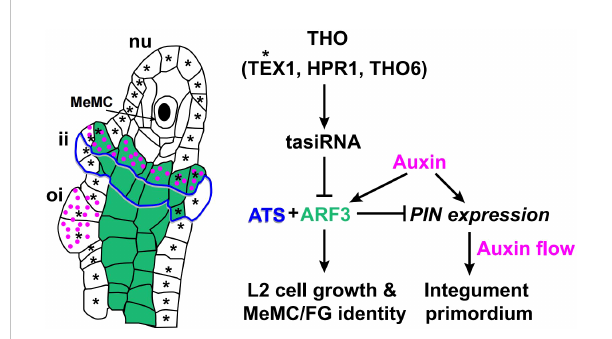
development. ARF3 is indicated in green, auxin in magenta, tasiR- ARF in gray, and ATS in blue with shades of gray (Kelley et al., 2012). Green area indicates the distribution of ARF3 (Su et al., 2017; Lora et al., 2019). The magenta dots indicate the distribution of auxin. Blue lines with shades of gray indicate the distribution region of ATS. Asterisks indicate the distribution of TEX1. Solid arrows indicate positive regulation. Block lines indicate negative regulation. nu, nucellus; ii, inner integument; oi, outer